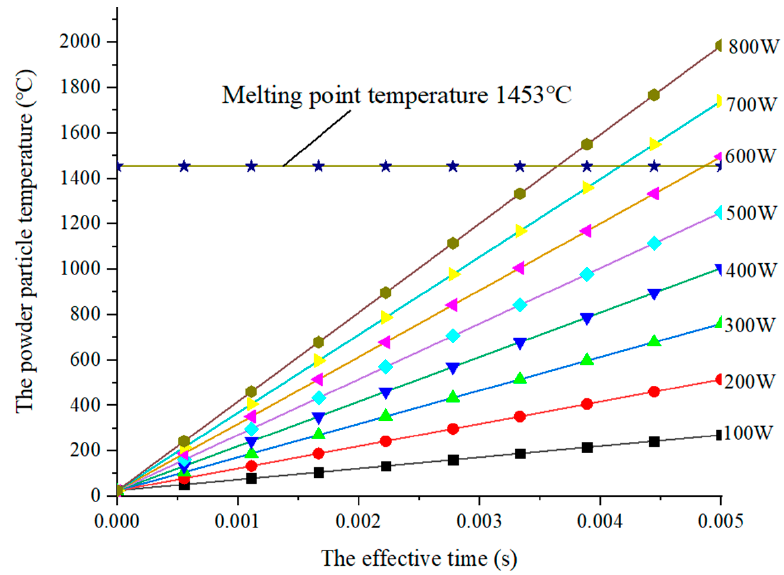
Figure 3. Single powder particle temperature change